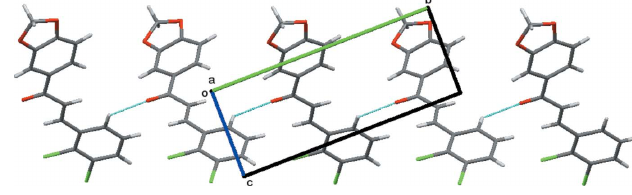
Figure 2 Packing of the molecules, viewed along the b axis, with hydrogen bonds shown as blue lines.